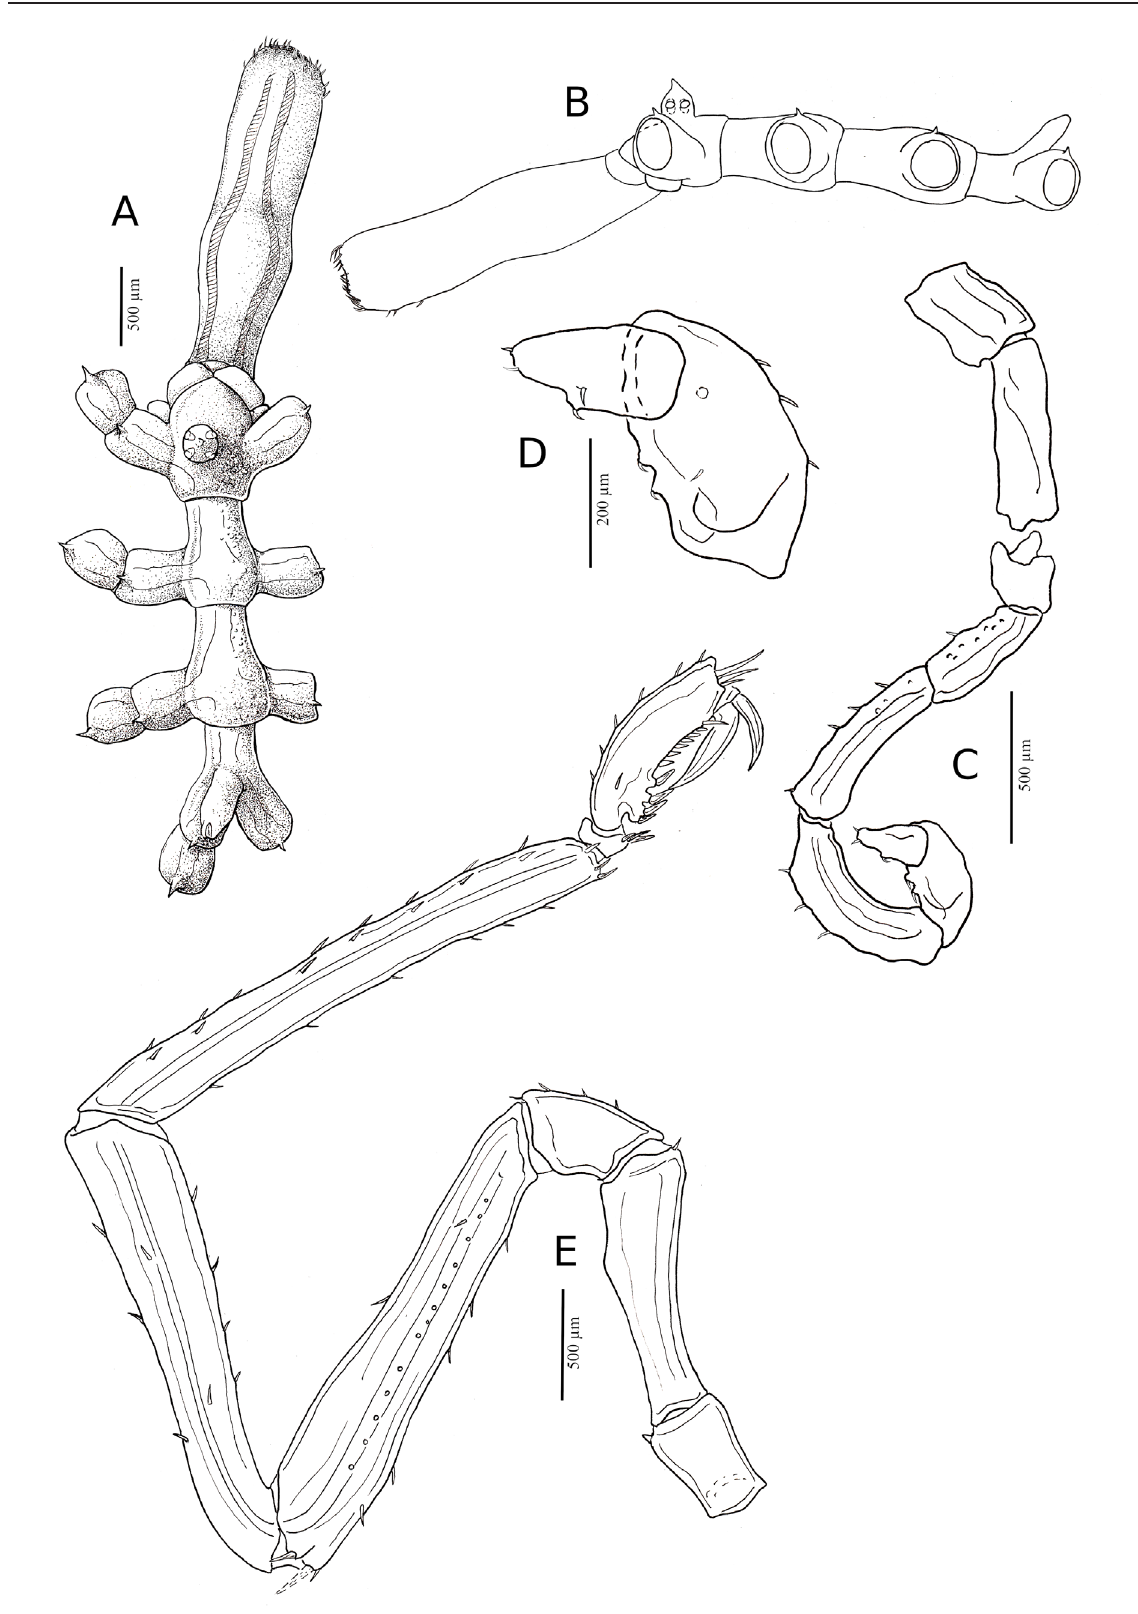
Fig. 18. Endeis aff. mollis (Carpenter, 1904), ♂, MNHN-IU-2016-565. A . Body, dorsal view. B . Body, lateral view (same scale as A). C . Oviger. D . Last two oviger articles. E . Third